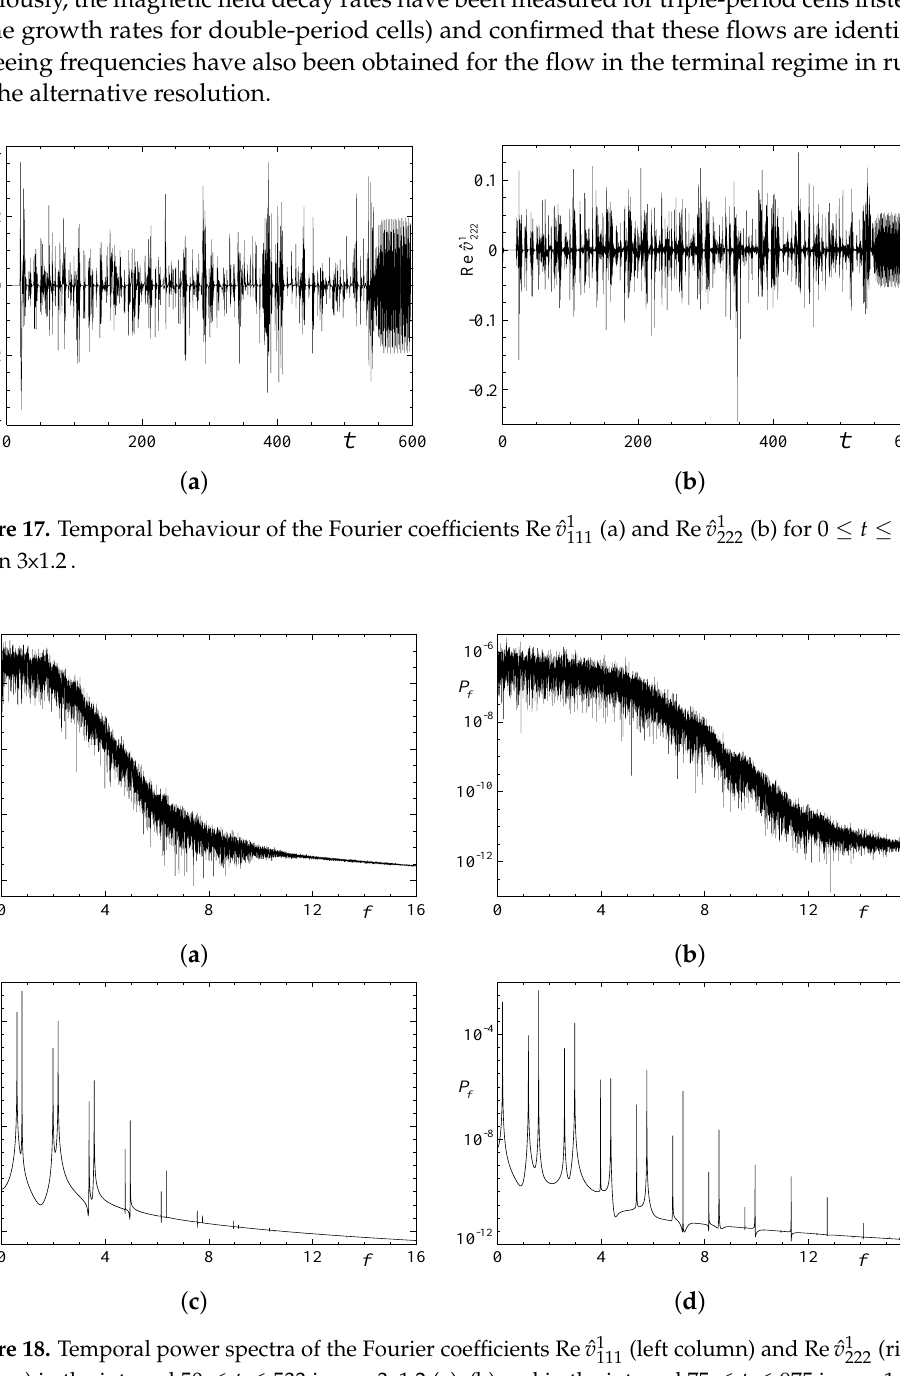
(left column) and Re ˆ v 1 (right 222 111